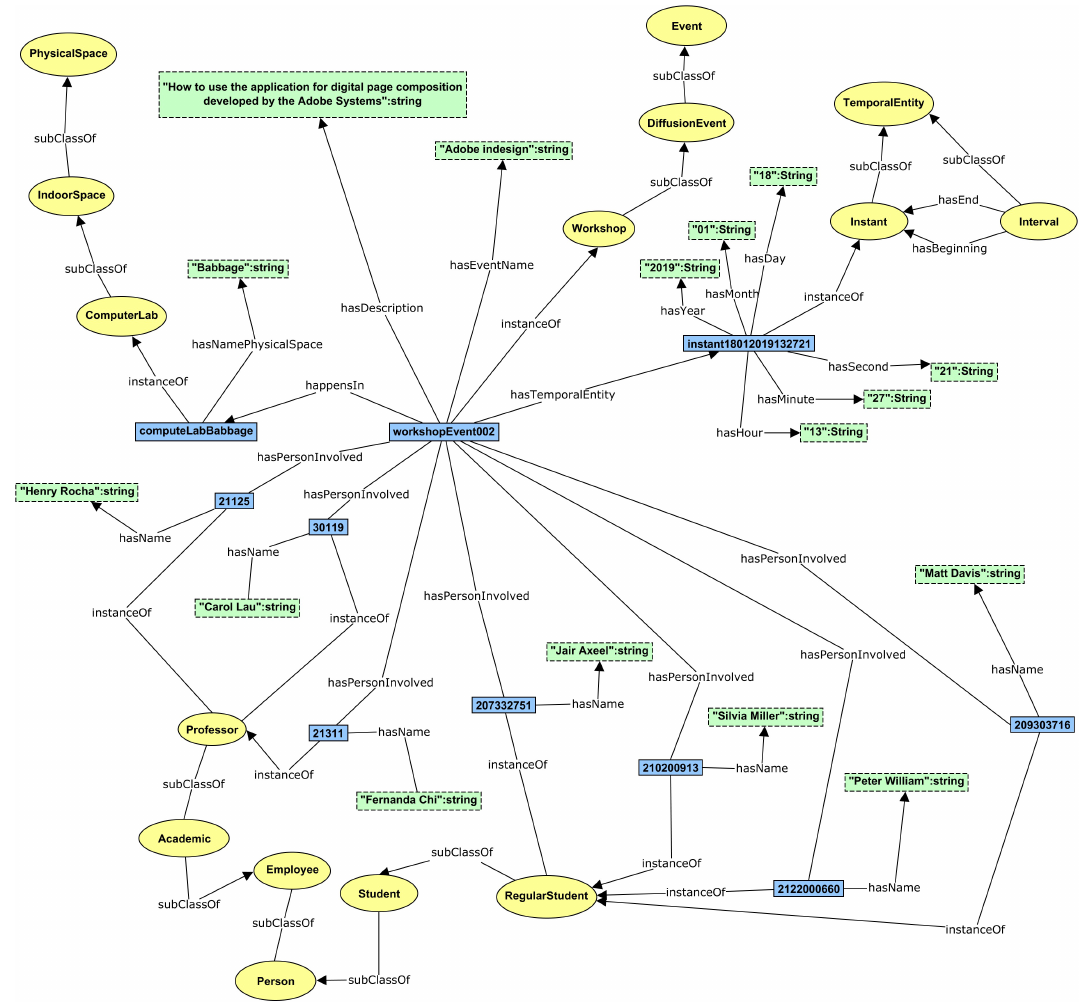
Figure 10. Ontological model instantiated with a diffusion event (scenario